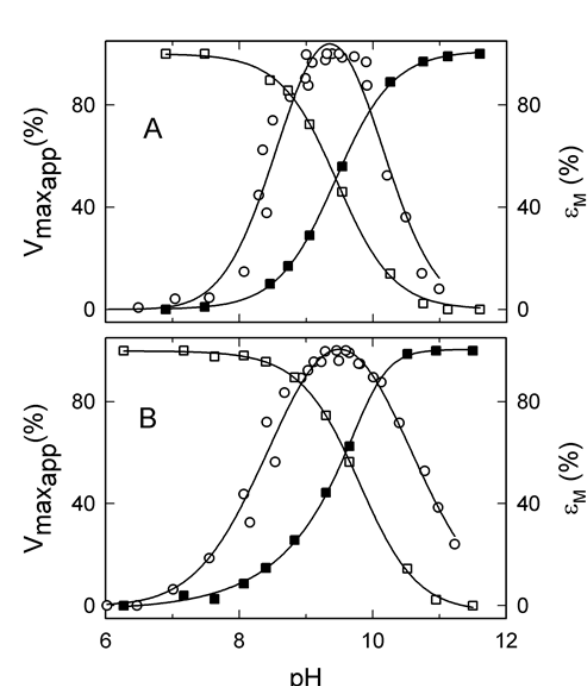
Figure 5: The normalized experimental data of Glu + 3-PHP reaction of activity and spectral data of Figure 4 drawn in the same figure showing that pK of the internal aldimine and optimum activity overlap: PSAT-BALC (A) and PSAT-BCIRA